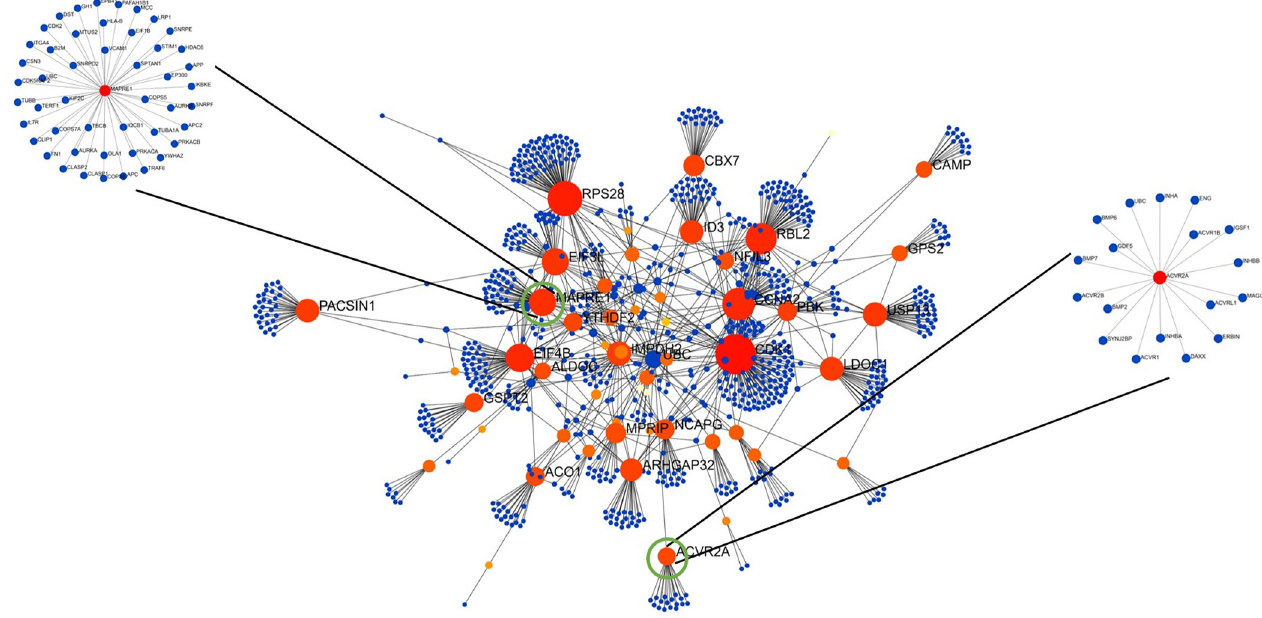
Fig 5. Protein-Protein Interaction network of gene signatures common between RA and SLE. The most highly ranked nodes were CDK1 (degree: 146, betweenness: 112412.8), RPS28 (degree: 94, betweenness: 66300.6), and CCNA2 (degree: 77, betweenness: 46749.4). The size and the colour of the nodes were layout by the degree and betweenness